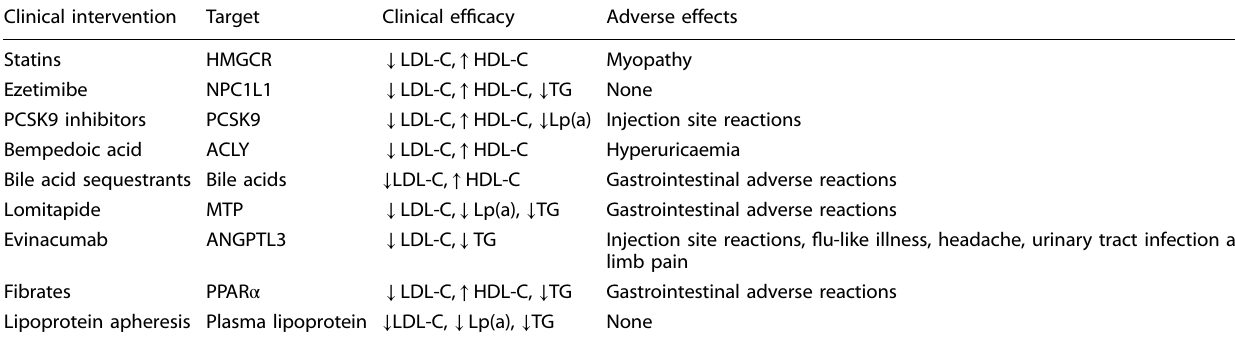
Table 1. The application of clinical cholesterol-lowering interventions on ASCVD Clinical